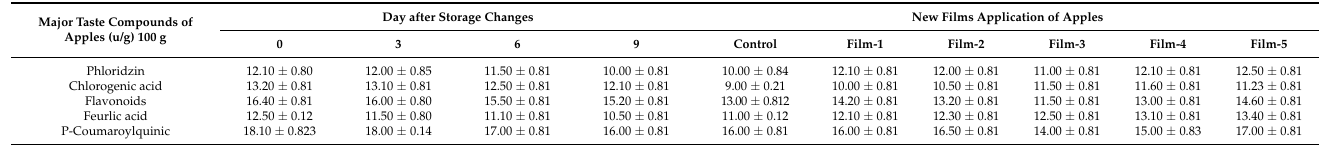
Table 8. Comparisons (DAS and treated fruits) of new and taste related major bioactive compounds isolated from pulp of (Golden Delicious) using HPLC-DAD methods.